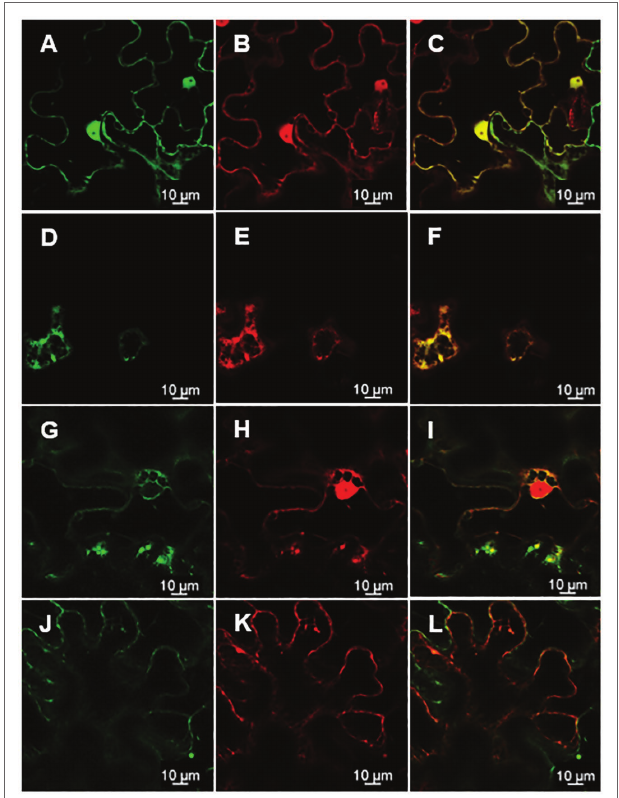
FIGURE 7 | Position of the eGFP tag on rolC affects its subcellular localization as visualized by confocal microscopy of N. benthamiana epidermal leaves. (A) rolC fused to eGFP on its C-terminal end permeates through the nuclear pores and can be found inside the nucleus (B) as confirmed by soluble mRFP1 control, panel (C) is an overlay of signals from rolC-eGFP and mRFP1 demonstrating complete co-localization of both proteins. (D) Soluble proteins fill out the cytoplasm around the cortical ER as observed for rolC-eGFP and (E) mRFP1, panel (F) is an overlay of signals from rolC-eGFP and mRFP1 demonstrating complete co-localization of both proteins. (G) rolC fused to eGFP on its N-terminal end observed on the nuclear membrane. (H) Soluble mRFP1 permeates into the nucleus. Panel (I) shows incomplete co-localization of eGFP-rolC and mRFP1. (J) rolC fused to eGFP on its N-terminal end. (K) Soluble mRFP1. (L) Overlay of signals from eGFP-rolC and